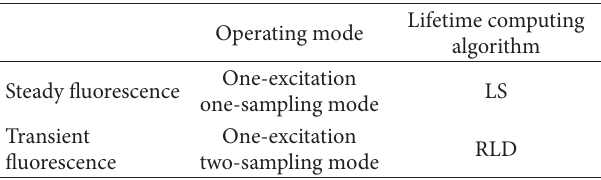
Table 4: Operating mode and lifetime computing algorithm for different